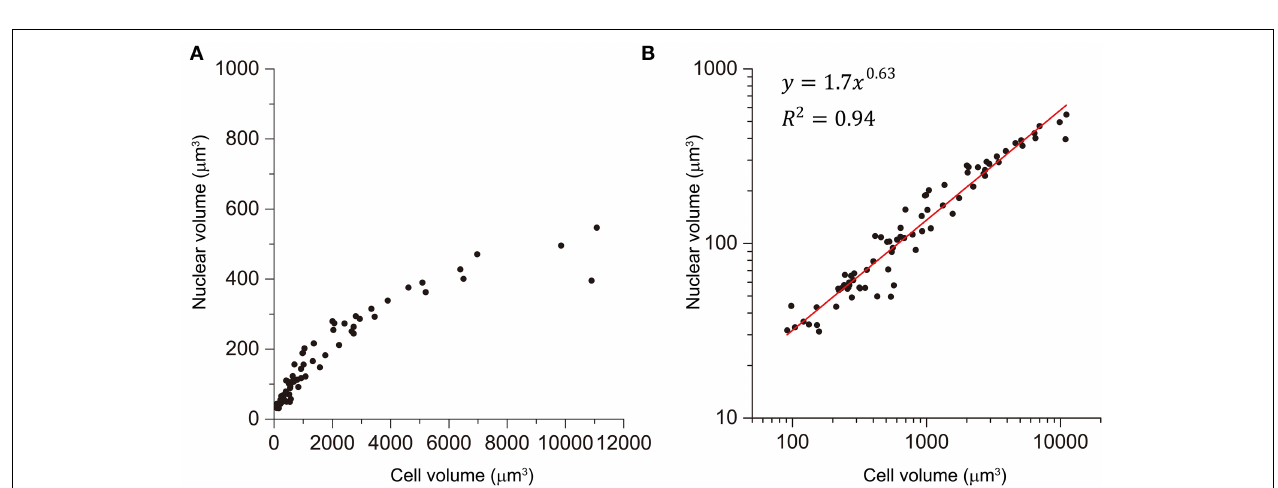
FIGURE 5 | Power law relationship between the nuclear and cell volume. Relationship between nuclear and cell volume in size-correlated classes (AB, MS, C, and P) is shown in linear (A) and double logarithmic (B) plots. Cell volumes were determined by the integral approach with error correction,